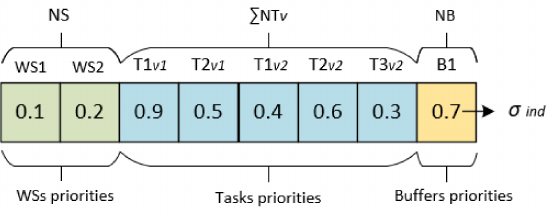
Figure 2. Solution